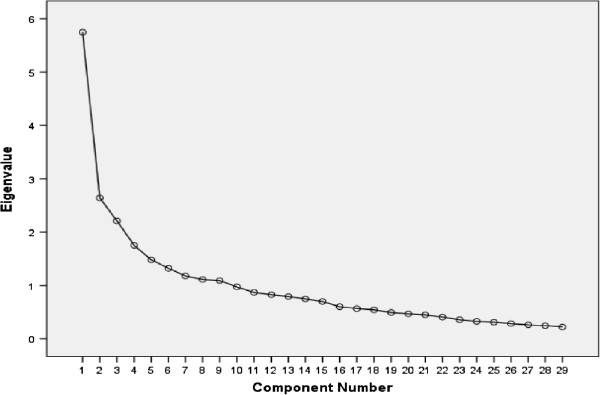
29-item MLCDP scree plot showing the amount of variance (see Appendix).